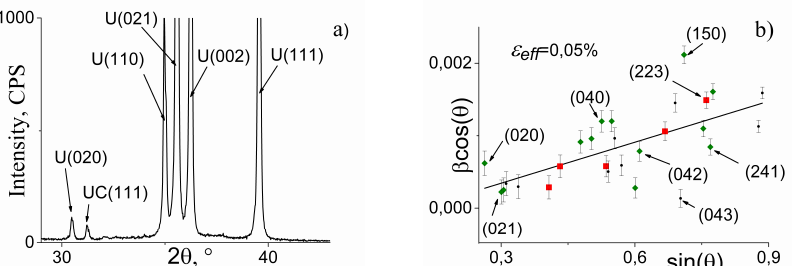
Fig. 3. Initial state of material. a) Diffraction spectrum region. Characteristic copper radiation. Lines of  -uranium and uranium carbide are noted. b) Williamson-Hall plot. Dispersion of points is much greater than the error estimate. Hard lines are denoted by squares, soft lines — by rhombi, and average lines — by